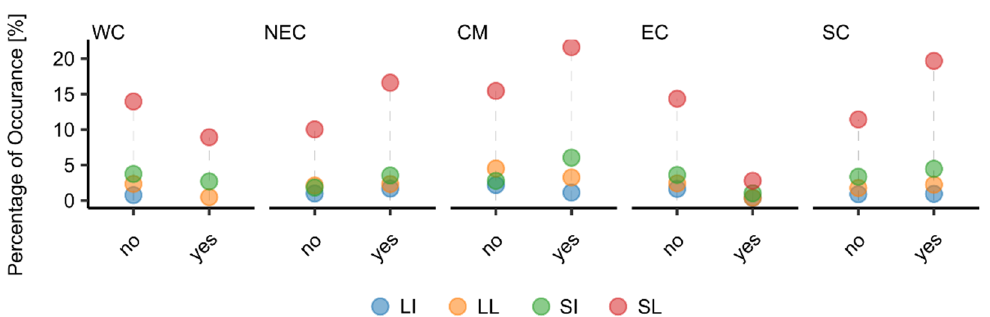
Figure 7. Percentage of precipitation events divided into four precipitation event classes per region taking into account the occurrence of local winds (yes; 1078 precipitation events) on the day of the event in comparison to days without diurnal breeze systems (no; 3074 precipitation events).